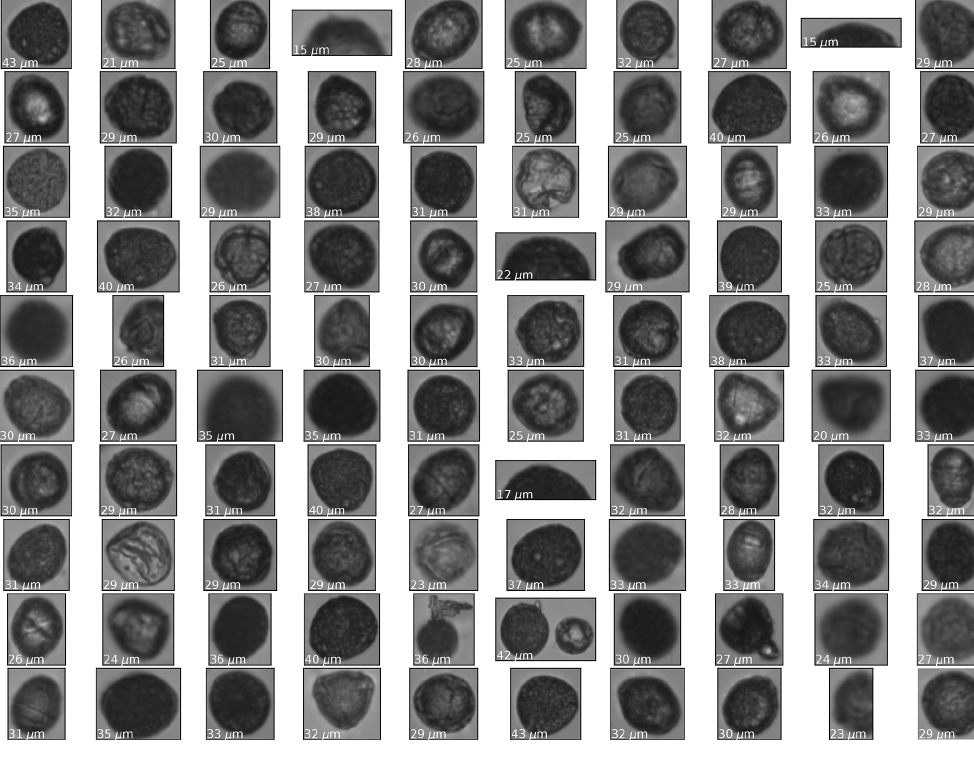
Figure C6. Quercus suber pollen.